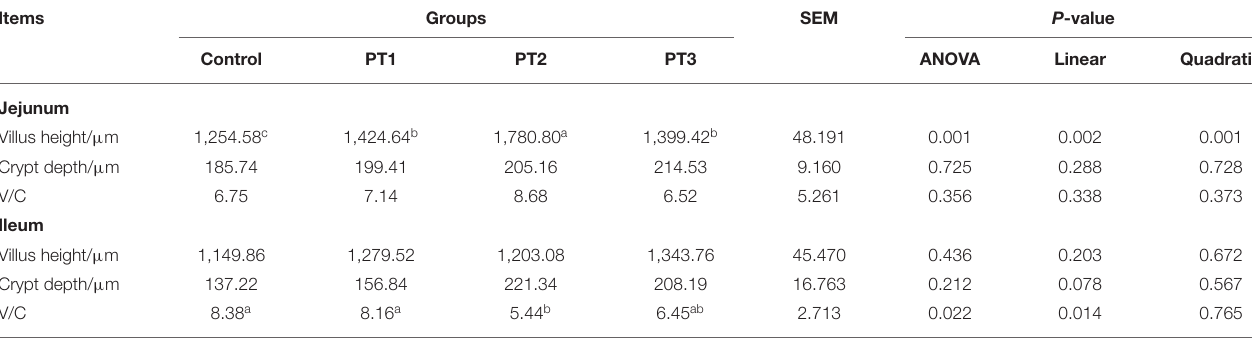
TABLE 5 | Effects of Plotytarya strohilacea Sieb. et Zuce tannin on intestinal morphology of the broilers at 42 days of age. Items Groups